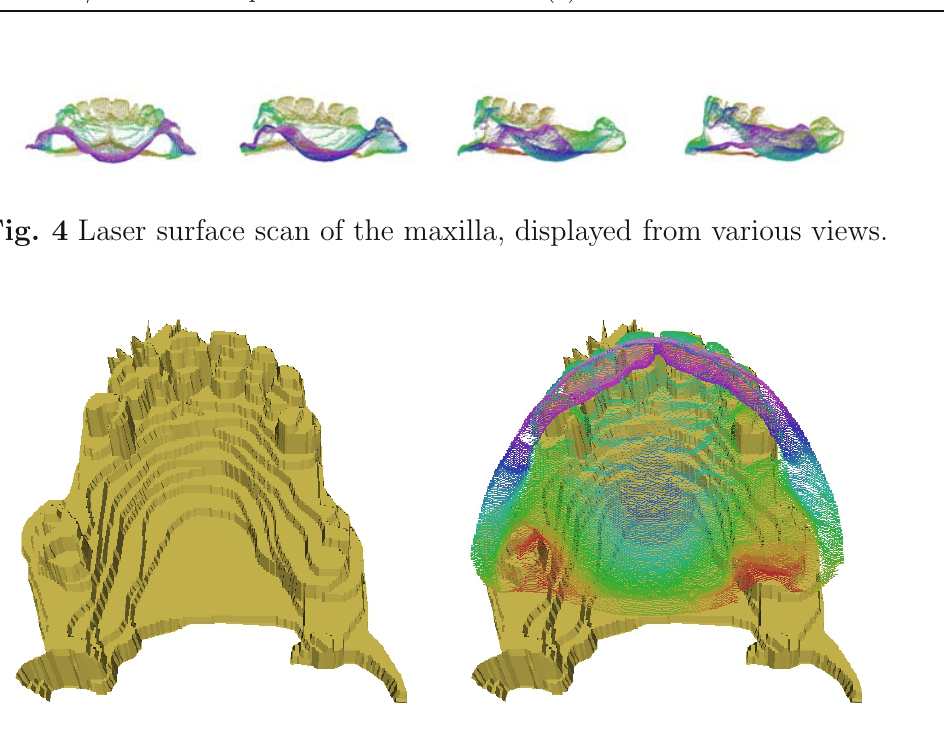
Fig. 5 Surface reconstruction of maxilla and dentition from CT data (left), with laser surface scan superimposed (right).